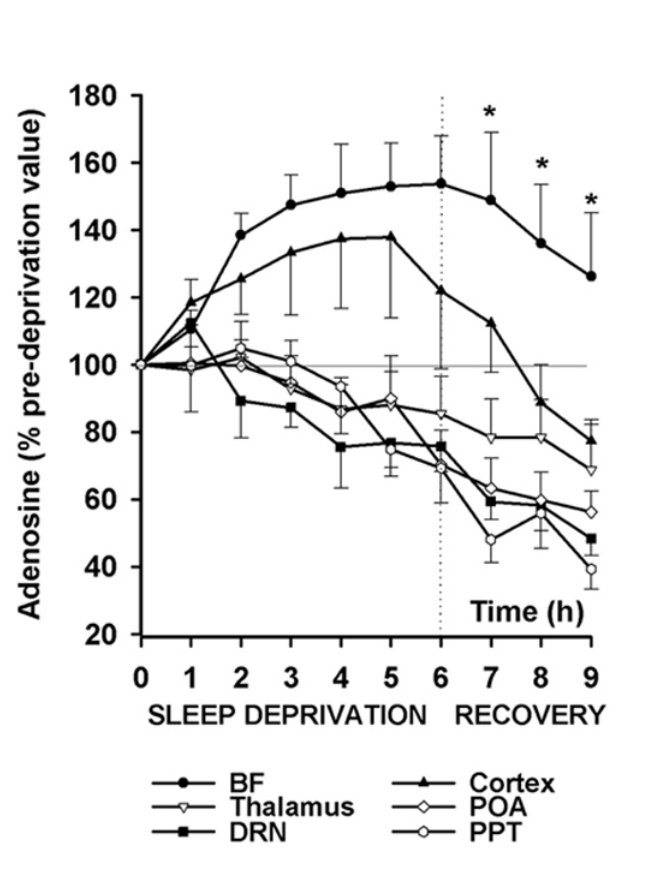
FIGURE 3 . Adenosine concentrations in different brain areas during sleep deprivation and recovery sleep. Cats were kept awake for 6 h. Prior to the beginning of the sleep deprivation, samples were collected to obtain baseline wakefulness values for each probe (predeprivation value = hour 0; defined as 100%). Two patterns were evident in the sleep deprivation–induced changes in adenosine; in the basal forebrain (BF) and cortex adenosine levels could be seen to rise during the sleep deprivation, whereas in the other four areas adenosine levels were either stable or declined slowly during the 6 h of sleep deprivation. During recovery, sleep adenosine concentrations were significantly higher in the BF than in all other areas. Significant differences in adenosine concentration between BF and all other areas are marked with asterisks. Abbreviations: DRN, dorsal raphe nucleus; POA, preoptic hypothalamic area; PPT, pedunculopontine tegmental area (modified from